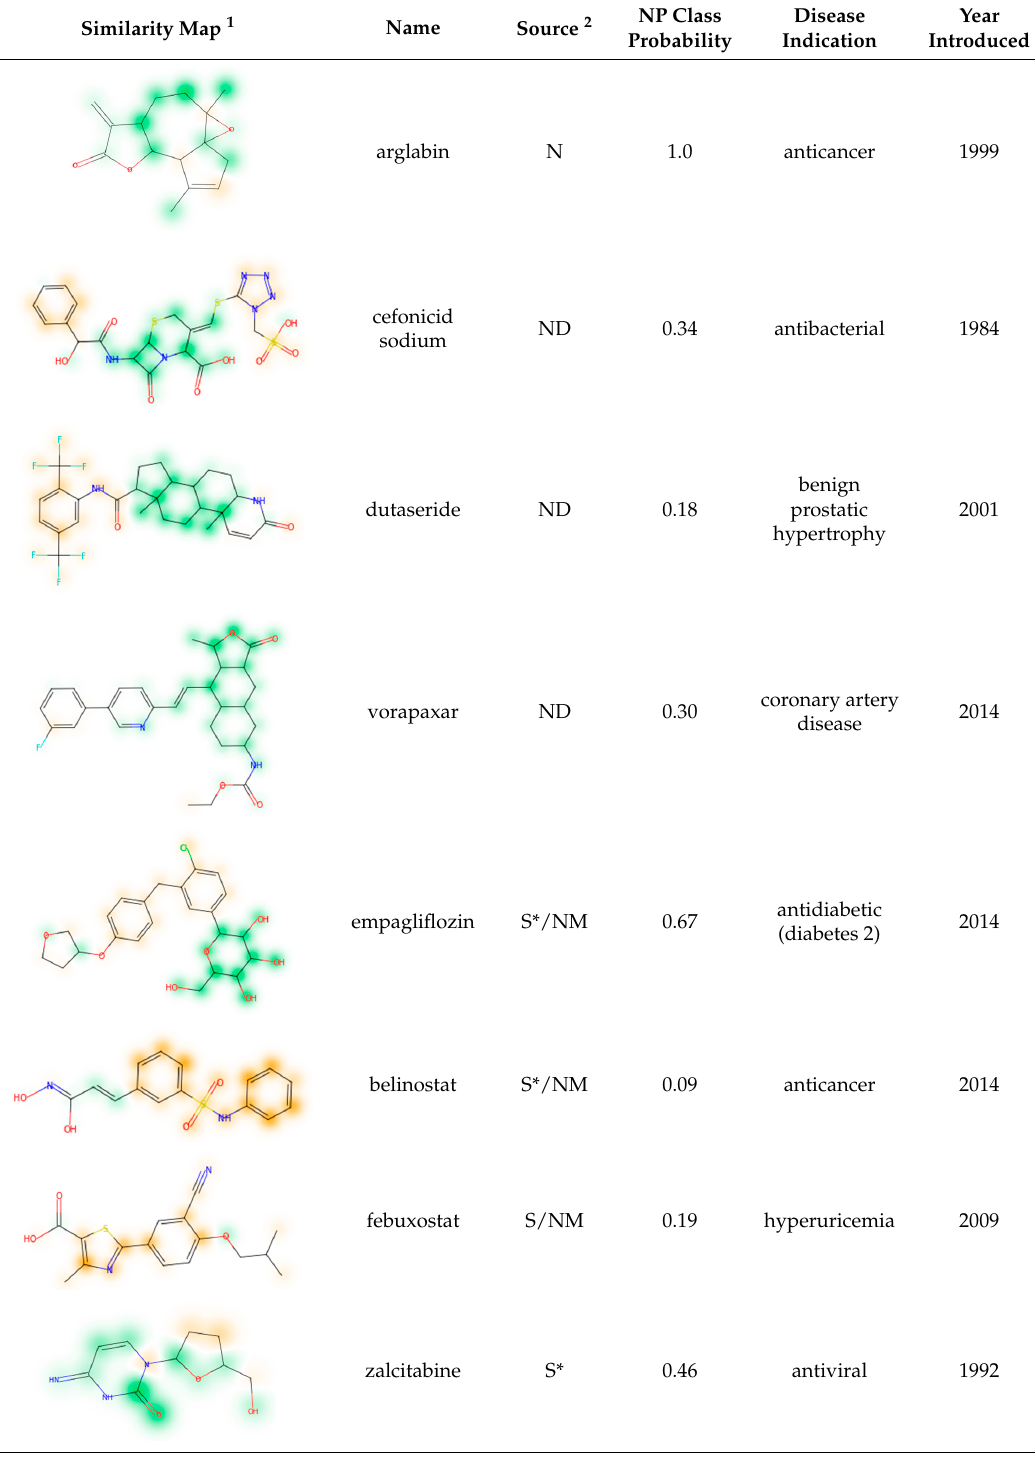
Table 4. Examples of similarity maps generated by the NP classifier based on Morgan2 fingerprints.